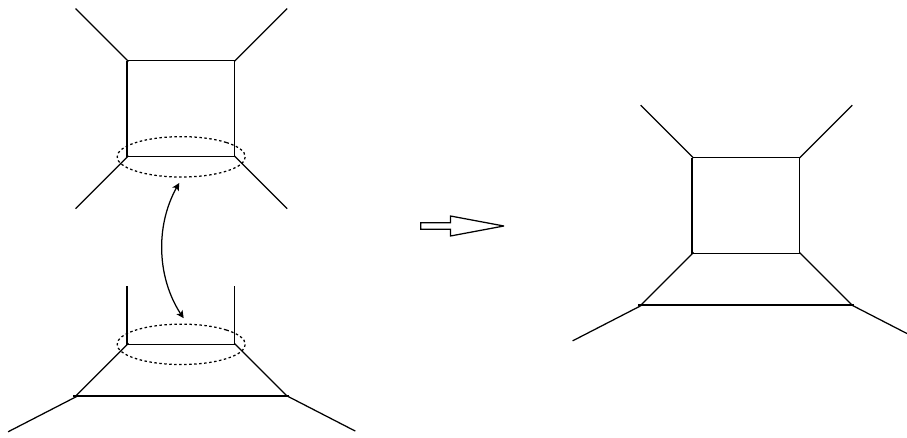
Figure 2. Example of a gluing construction of the K(cid:127)ahler surface S = F 0 in both surfaces, C 1 ; C 2 , are encircled by dashed lines in the left (cid:12)gure. The (cid:12)nal geometry (on the right) is the result of identifying these two curves subject to the conditions described in section